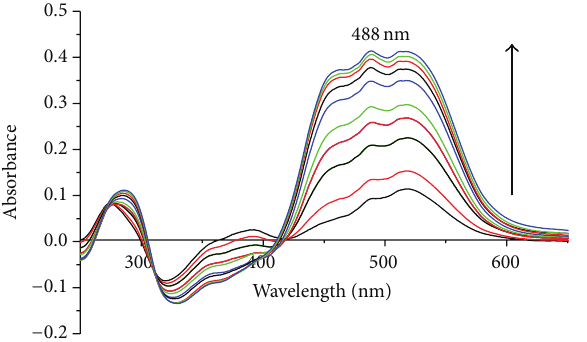
Figure 3: Absorption spectra of TEAC-Cr(III) complex at 488 nm with the increasing concentration of Cr(III) ion from 0.2 × 10 −5 M to 20 × 10 −5 M as TEAC blank.